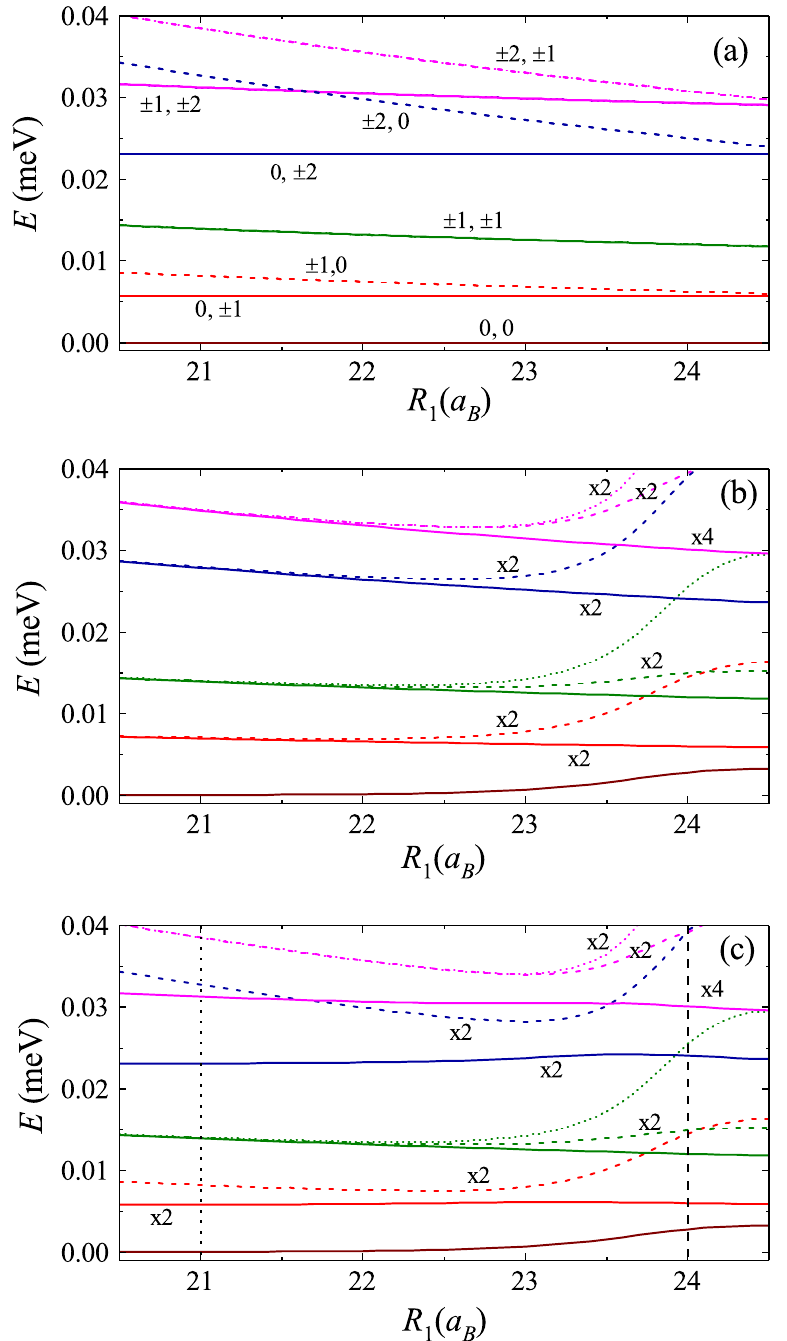
Figure 3. The energy spectrum of the two exciton dynamics. Here, the radius of external ring is chosen as R 2 = 25 a B : ( a ) the case of non-interacting excitons; ( b ) the mixing term is neglected; and ( c ) the full spectrum. The presence of Coulomb interactions lifts the energy degeneracy for the case of small distance between the rings ( b , c ), while the mixing term lifts the degeneracy in the limit of distant rings ( a , c ). The notation “xn” indicates the level of degeneracy. The notations in ( a ) are explained in the main